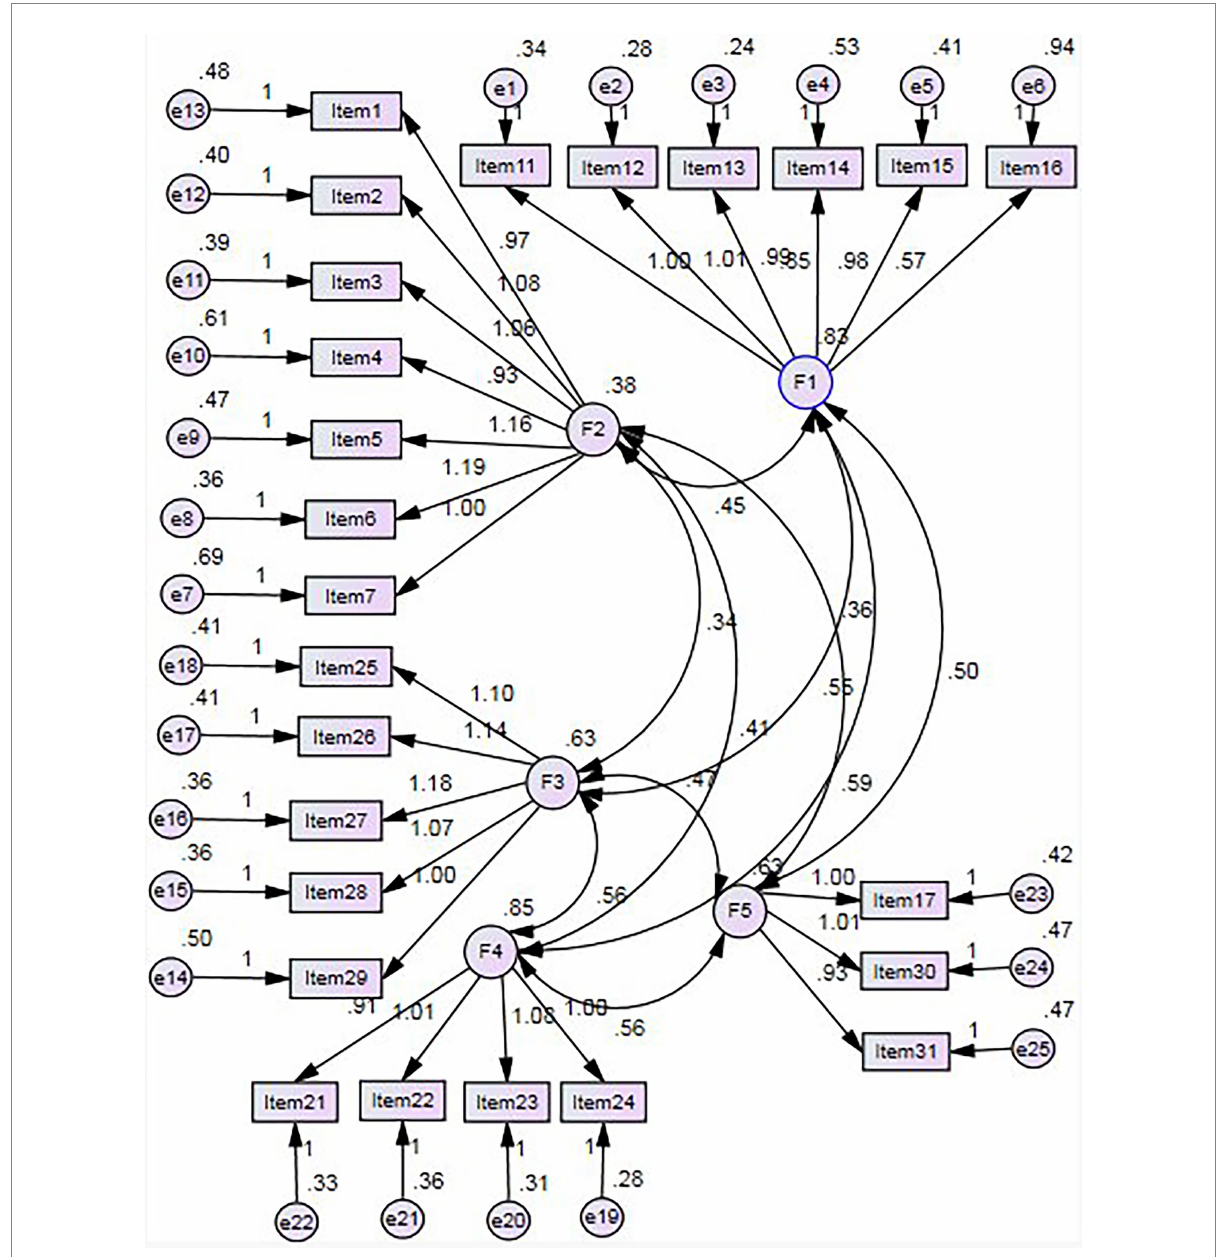
FIGURE 2 Structural equation model for the